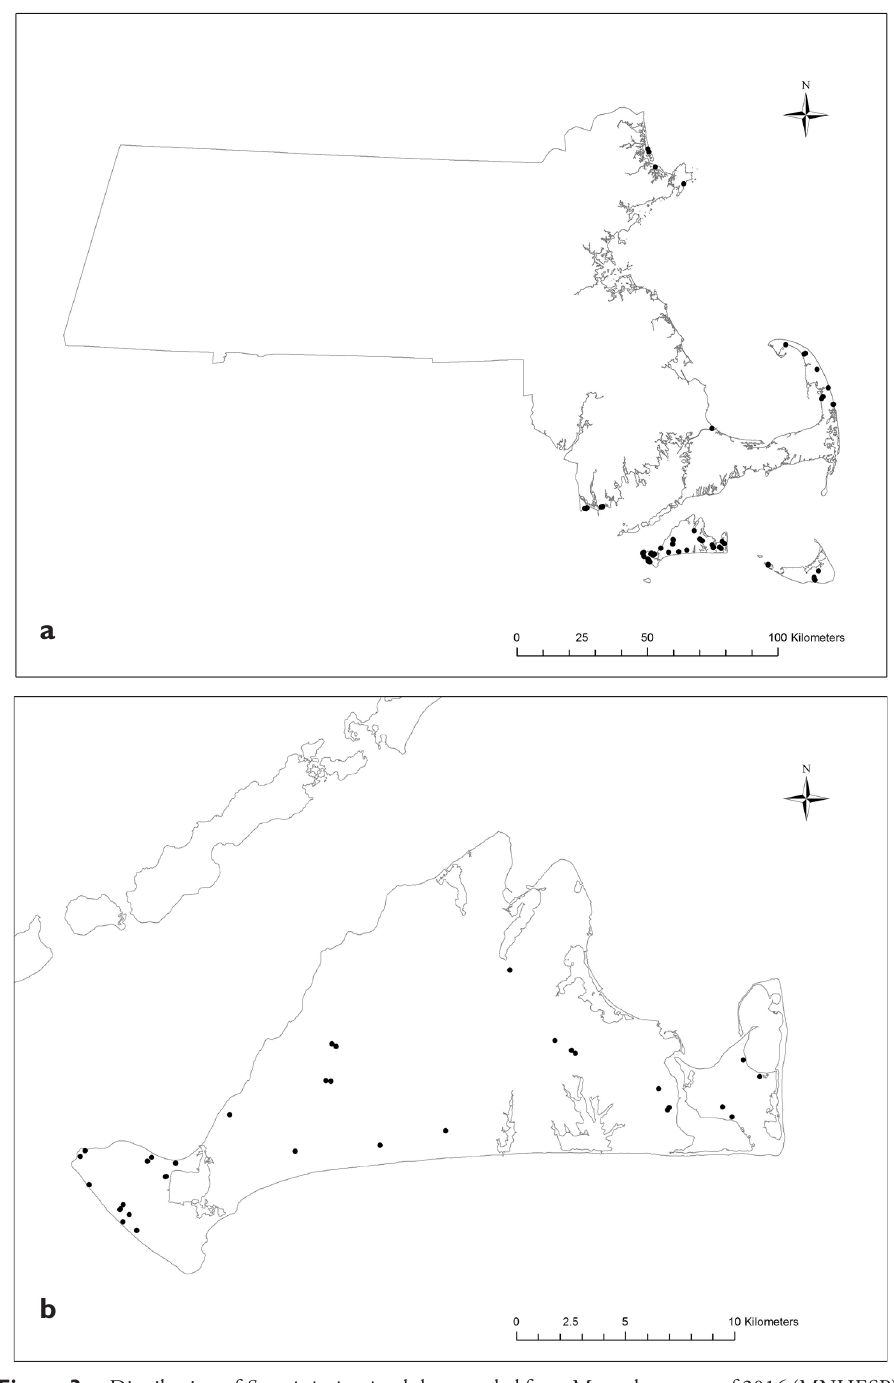
Figure 3. a Distribution of Sympistis riparia adults recorded from Massachusetts as of 2016 (MNHESP), b Distribution of Sympistis riparia adults recorded from Martha's Vineyard as of 2016